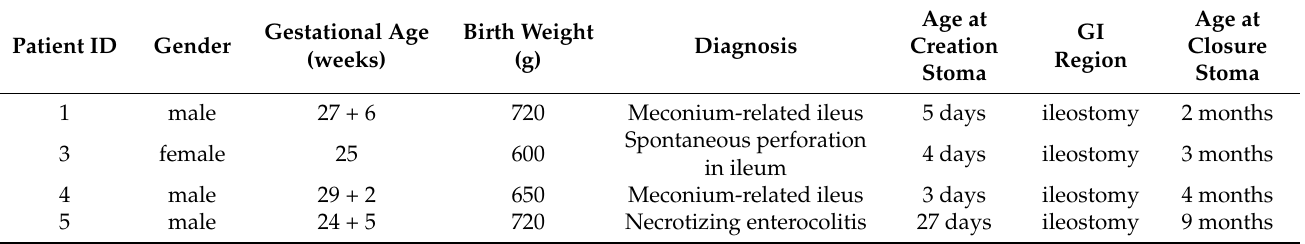
Table 1. Detailed clinical information of the four infants included in the measurement of potential differences of the luminal and mucosal